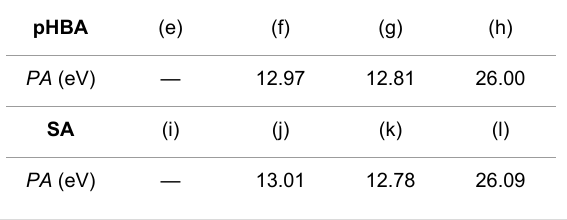
Figure 2. The energy of the electronic transitions, obtained by TD-DFT is a better indicator of the gap than the LUMO–HOMO energy difference determined by DFT [23]. Of all pollutants, salicylic acid has peaks at higher wavelengths, transition at 248 nm, a HOMO → LUMO+1 transition at 215